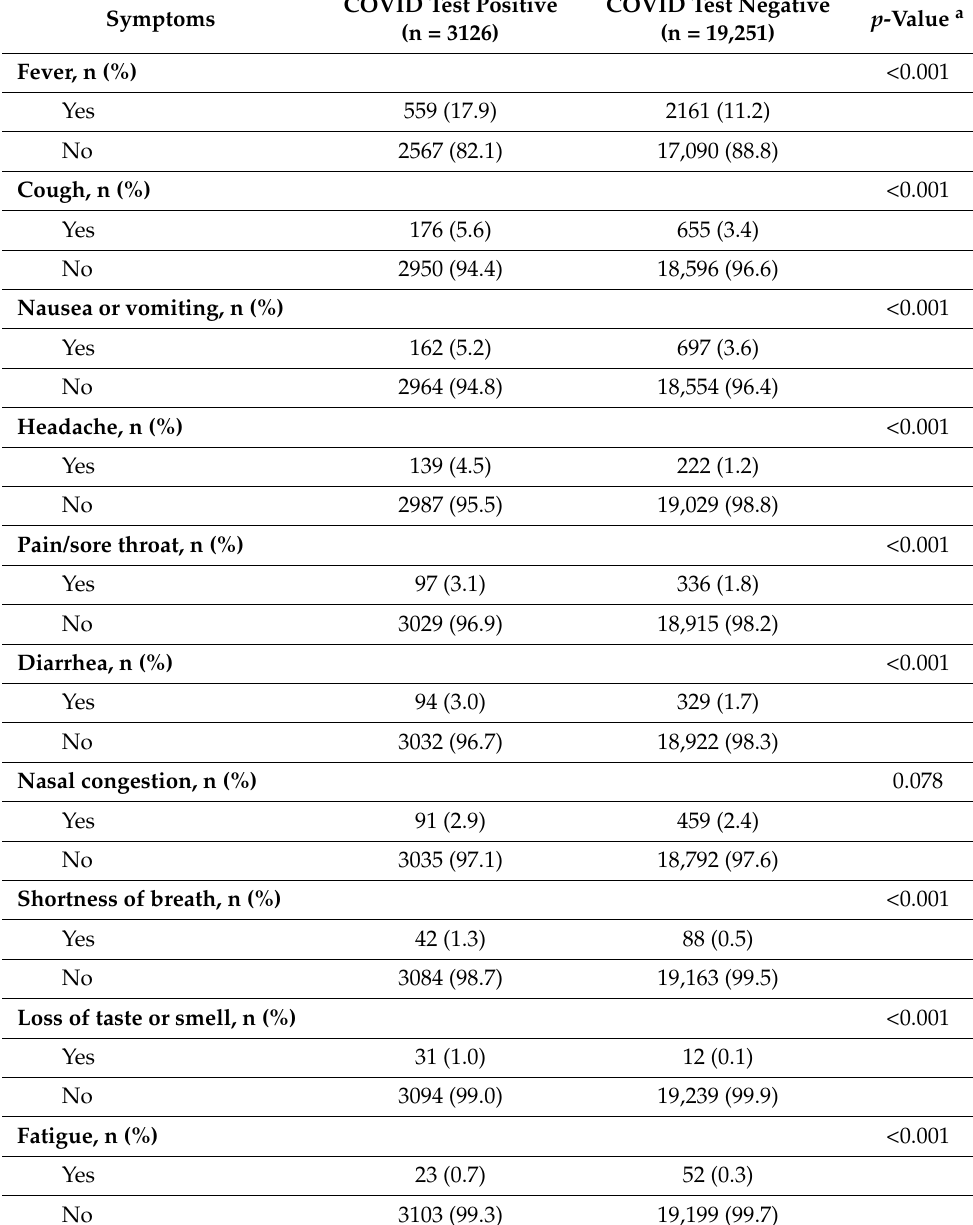
Table 2. COVID-19 test results by presenting